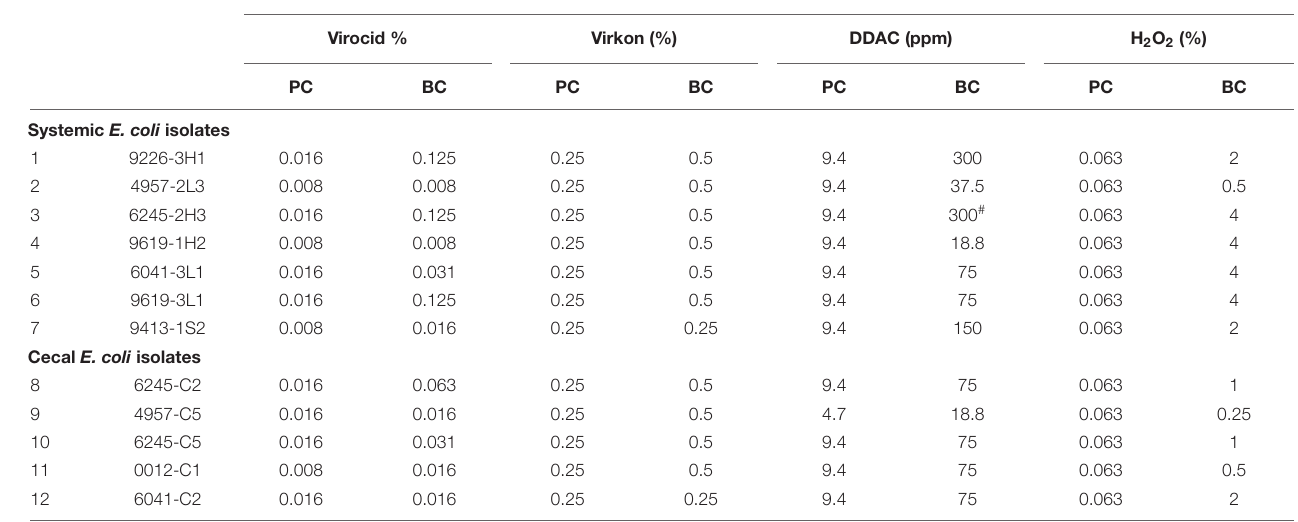
TABLE 2 | Bactericidal effect of disinfectants on planktonic and biofilm cells within 30 min of contact time. Strain